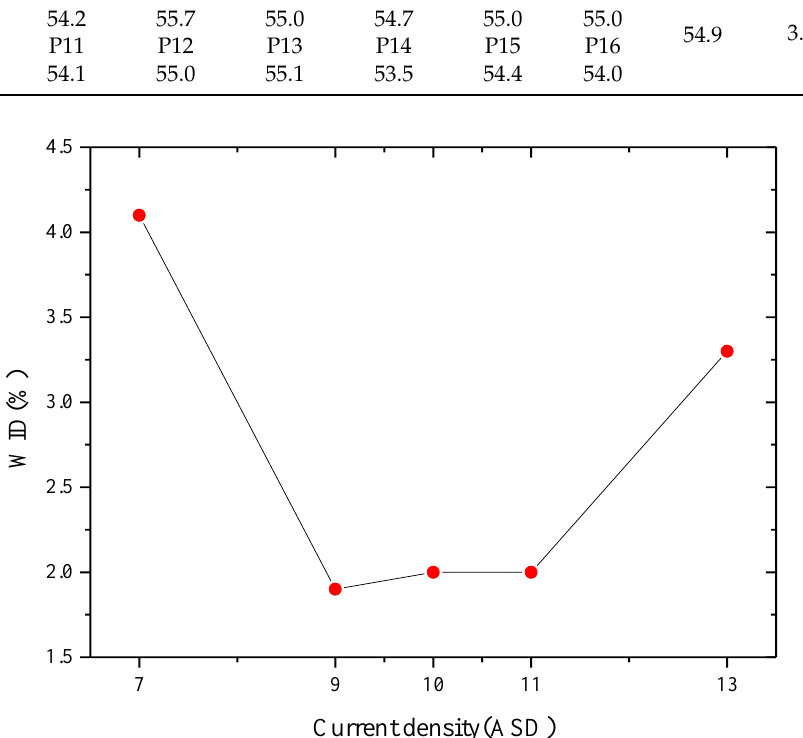
Figure 5. Height deviation of bump by current density, WID.